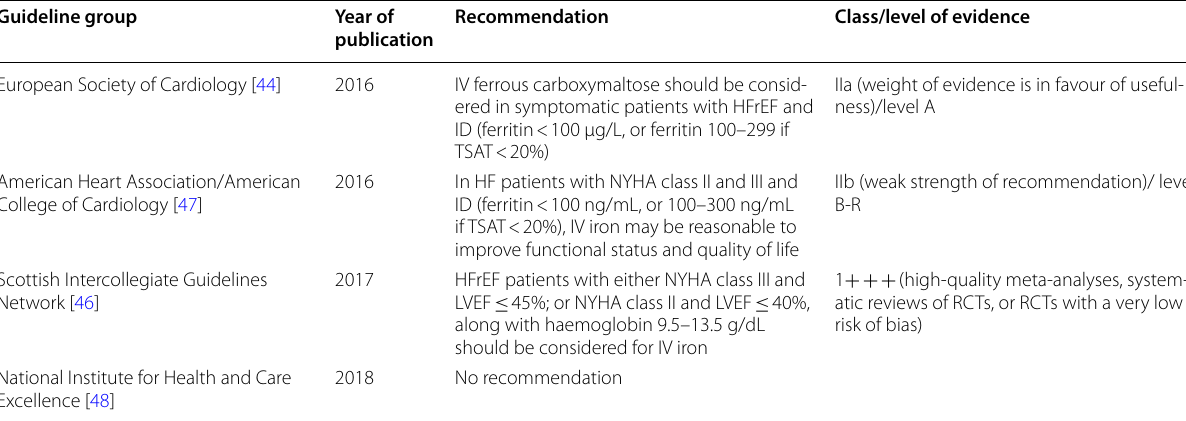
Table 2 Current guideline recommendations reagrding the use of intravenous iron in heart